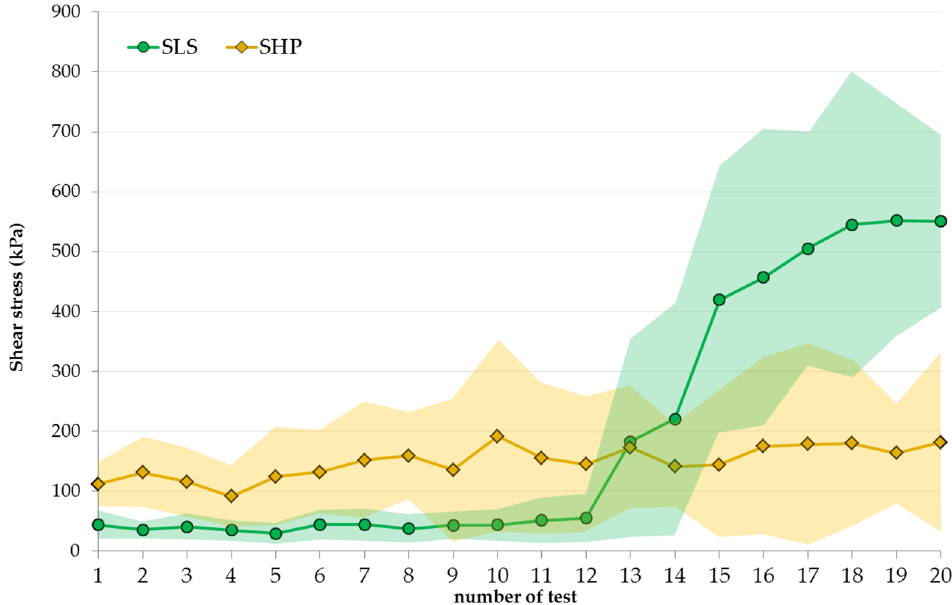
Figure 10. Durability of ice-phobic properties of SLS and SHP with repeated shear stress measurements. Pale areas represent the standard deviation for each value.